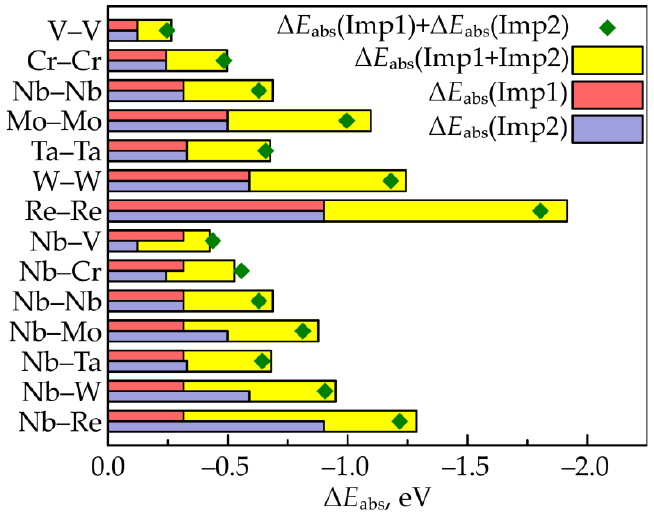
Figure 9. Change in the oxygen absorption energy due to alloying by one and two impurity atoms. between impurity atoms. Due to the presence of oxygen, these interaction energies differ from those earlier calculated and given in Table 3. A sufficiently high electronegativity of oxygen leads to O–Me bonds being highly ionic. Therefore, impurity atoms get a charge of the same sign that leads to a repulsion interaction. As a result, the interaction energy becomes positive for all considered pairs of atoms, which leads to an additional decrease in the oxygen absorption energy. Indeed, this can be seen from Figure 10. In this case, the correlation coefficient between the interaction energy and the energy difference ε is − 0.82, with the standard deviation of 0.022 eV. Considering just the effects of each impurity atom separately, the effect of two impurity atoms can be predicted as the sum of two corresponding contributions (Figure 11). In the case of such an estimation, the maximal error is 0.11 eV, and the relative error is less than 9%.